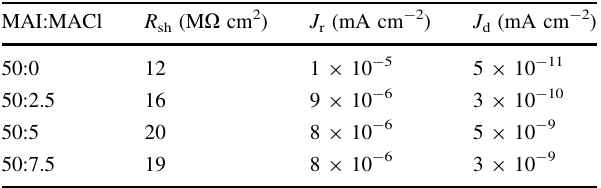
Table 4 R sh , J r , J d values derived from fitting dark current in Fig. 4a by using Eq. 14